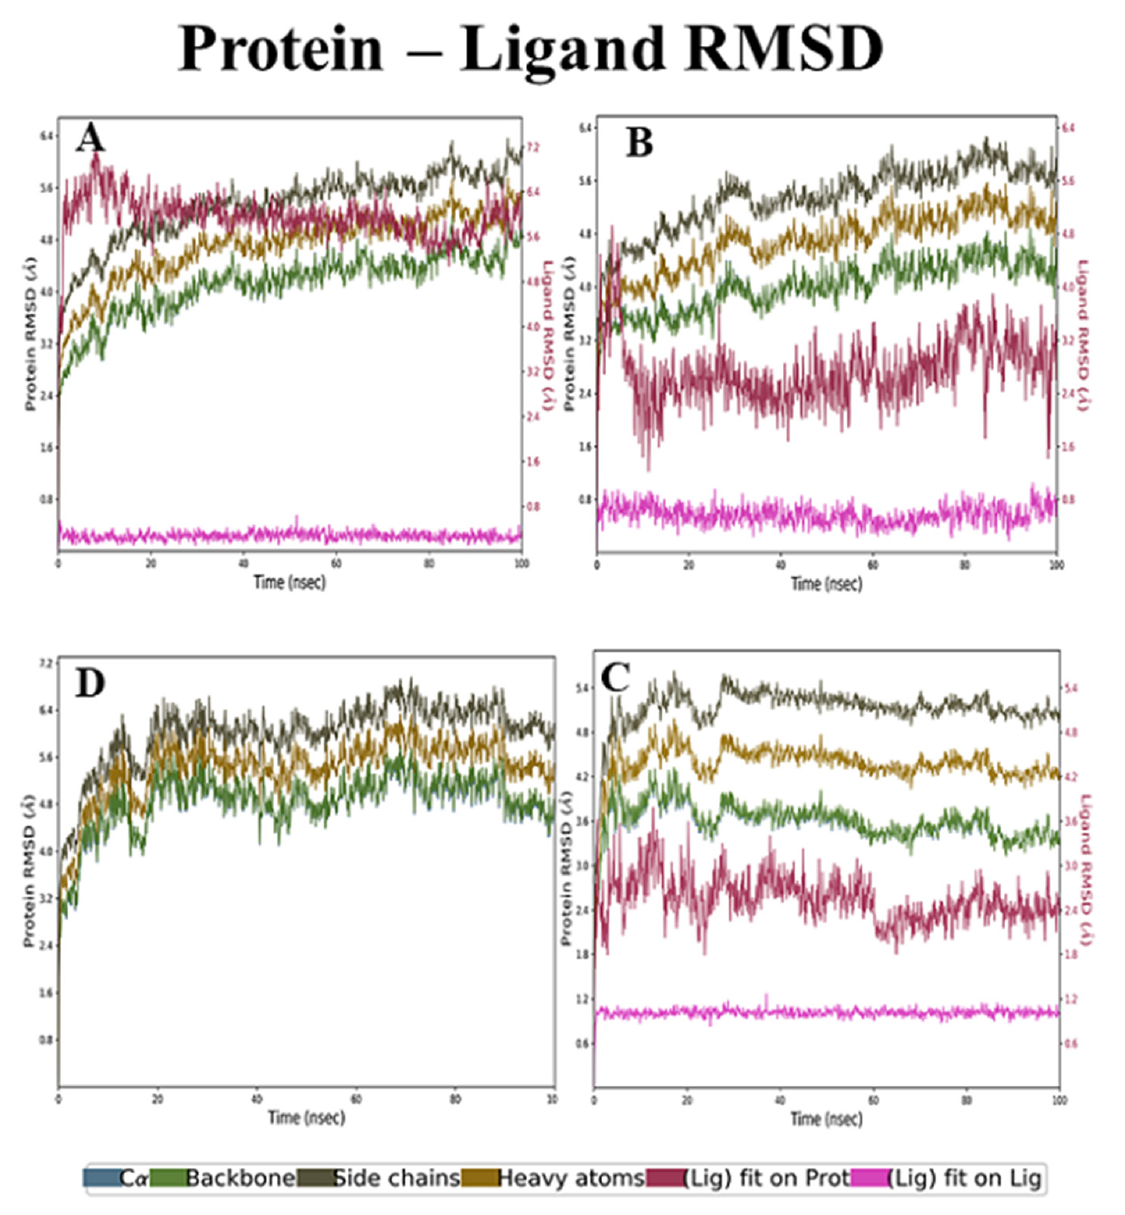
Figure 6. RMSD analysis of lead compounds and ECD GC-C protein complexes. ( A ) Holanamine, ( B ) Holadysenterine, ( C ) Pubescine, ( D ) No ligand.